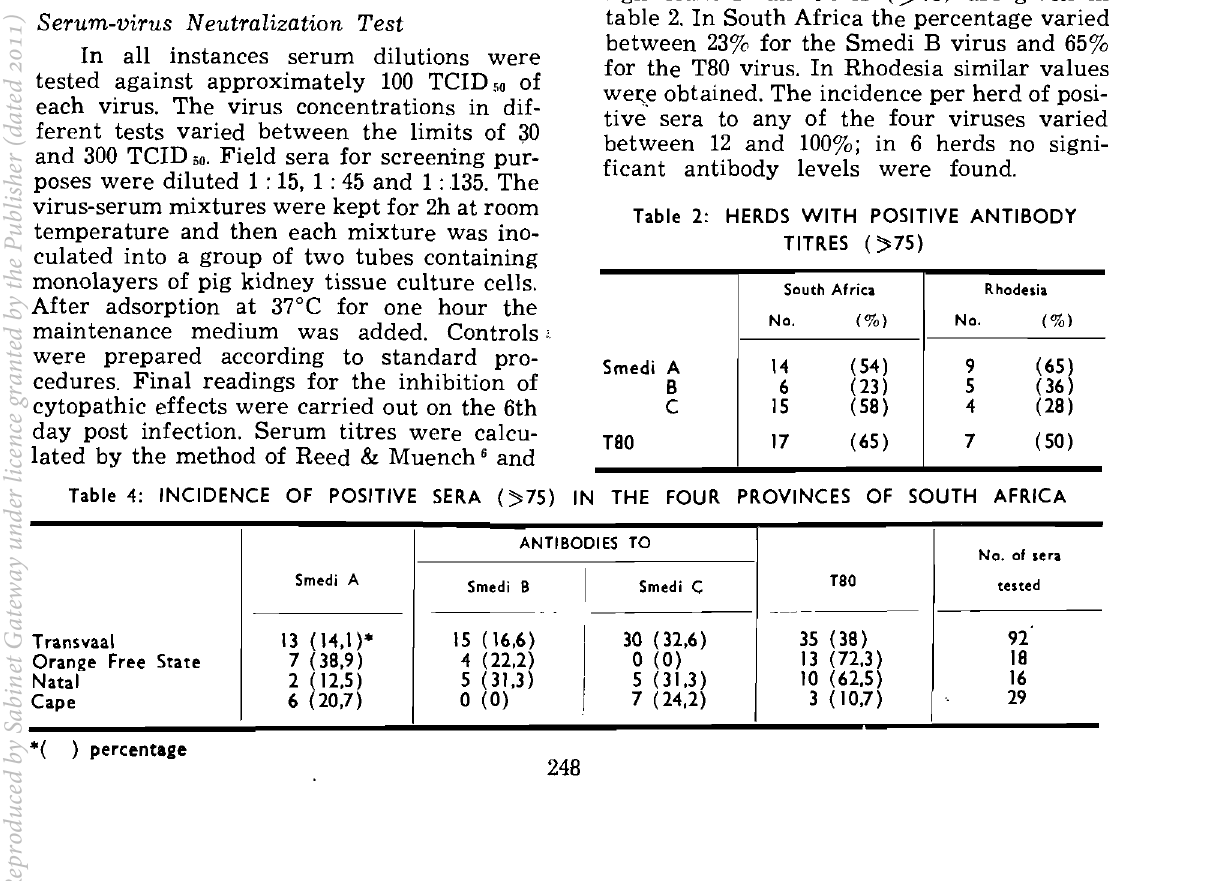
Table 1: ORIGIN OF THE SERA TESTED No. of herd.